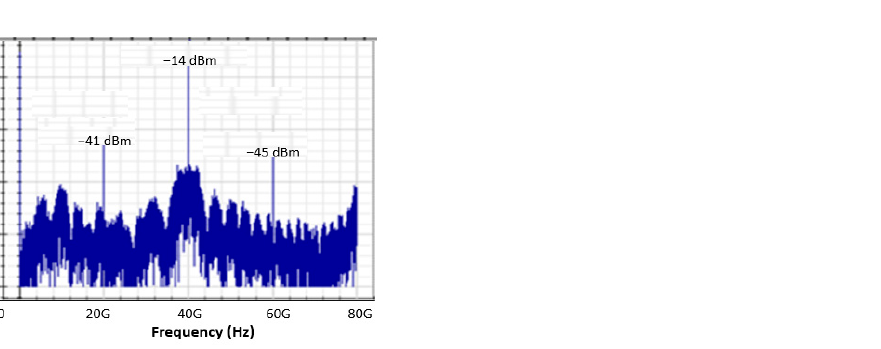
Figure 7. DSB-OCS electrical output spectra at different optical fiber lengths. ( a ) 0 km; ( b ) 10 km; ( c ) 20 km; ( d ) 30 km; ( e ) 40 km.